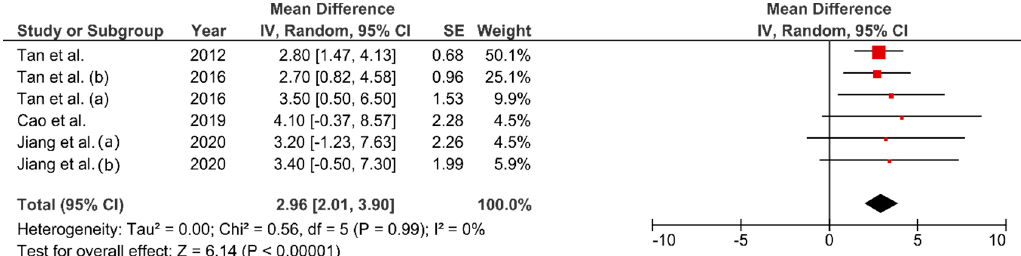
Figure 6. Pooled mean difference and 95% confidence interval for maximal oxygen consumption (ml ∙ kg − 1 ∙ min − 1 ) change in fatmax training experimental groups: baseline vs. after intervention. Positive values indicate an improvement in cardiorespiratory fitness.